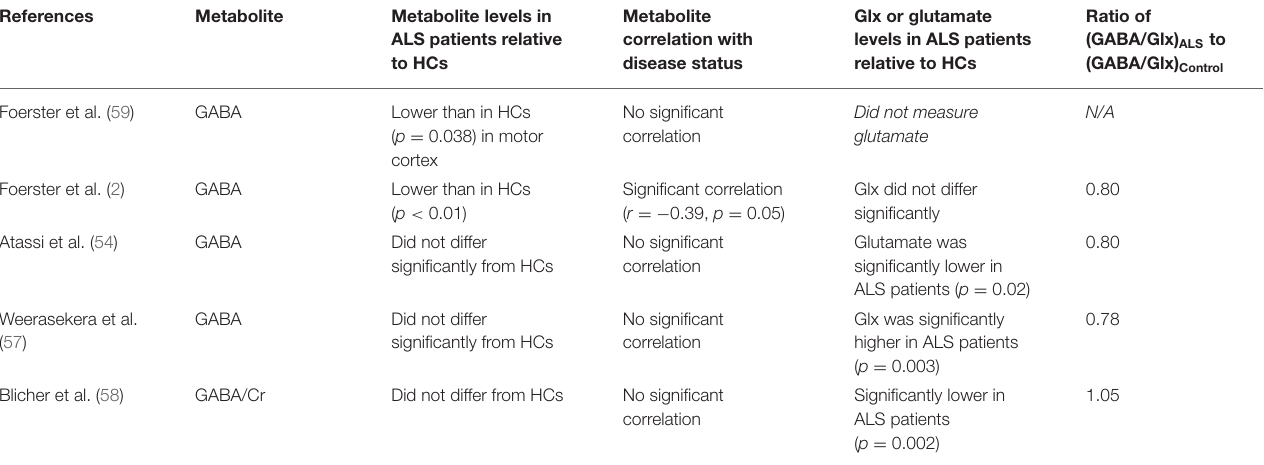
TABLE 3 | Results of 1 H MRS studies evaluating GABA in ALS